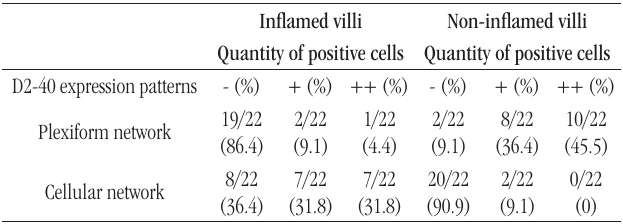
taBLE 2 − D2-40 expression in 22 cases of chronic villitis subdivided according to its expression pattern in inflamed and non-inflamed villi Inflamed villi Non-inflamed villi Quantity of positive cells Quantity of positive cells